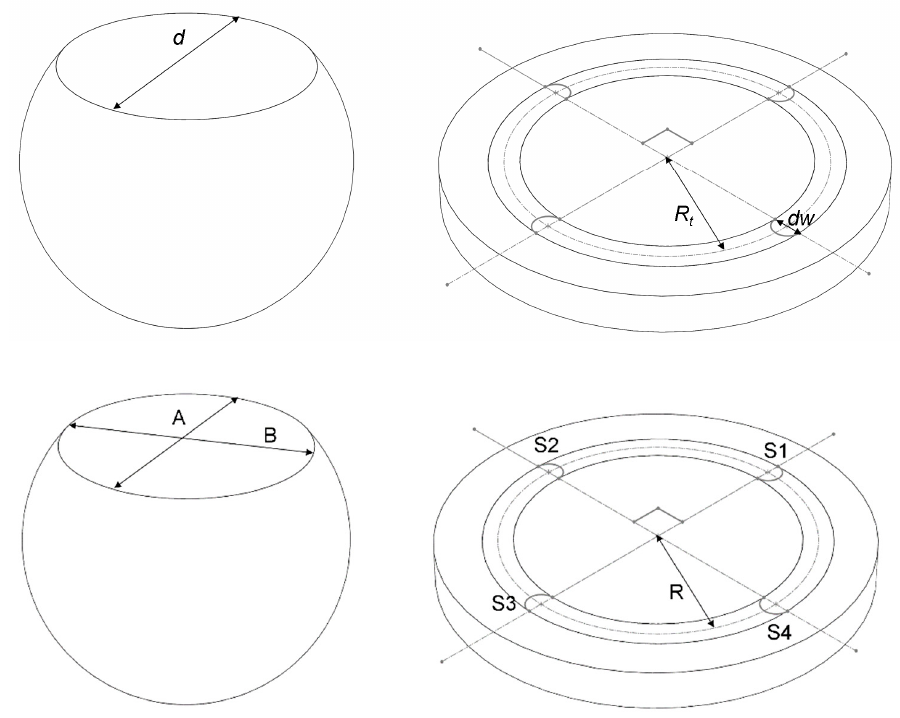
Figure 5. Wear parameter definition according to G99-95a ( above ) and according to ISO 18535 ( below ).